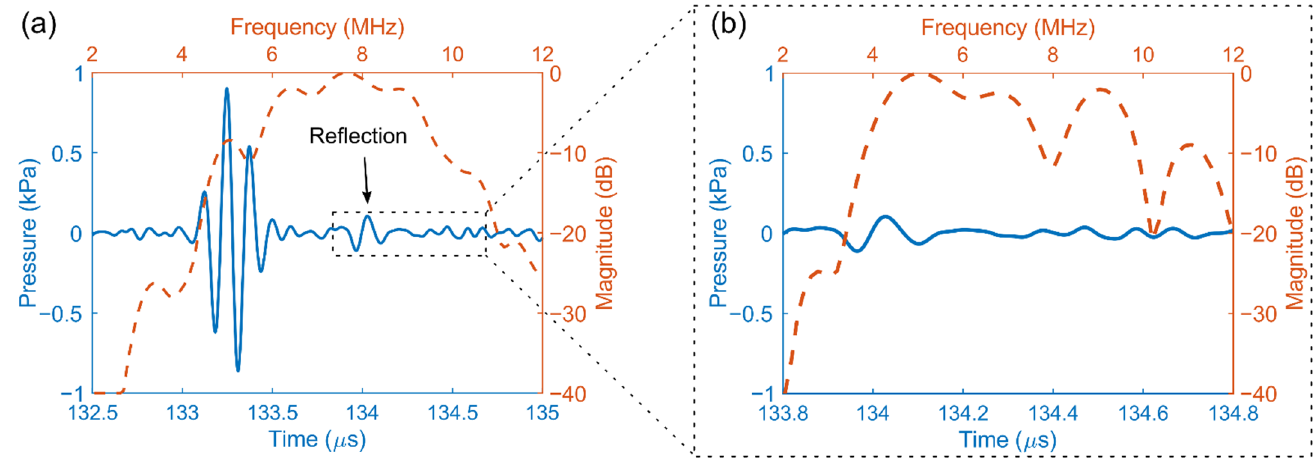
Figure 8. ( a ) Time and frequency domain response for a single element. ( b ) Close-up look at the second pulse.